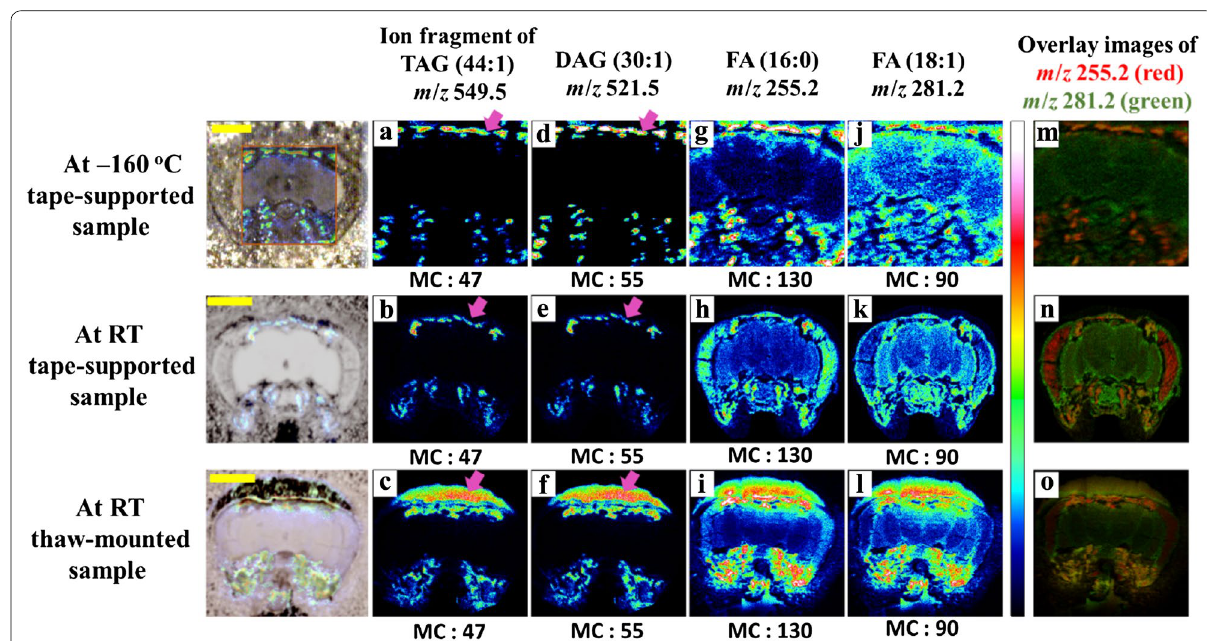
Fig. 3 Comparison of Drosophila brains prepared by three different preparation and analysis procedures. Tape-supported at low temperature ( a , d , g , j , m ), at room temperature ( b , e , h , k , n ), and thaw-mounted at room temperature ( c , f , i , l , o ). The distributions of positive ions at m / z 549.5—ion fragment of TAG (44:1), and 521.5—DAG (30:1), respectively, and negative ions at m / z 281.2 [FA (18:1), oleic acid] and m / z 255.2 [FA (16:0), palmitic acid]. Scale bar is 200 μm. MC stands for maximal counts (Reproduced from ref. [84] with permission, © John Wiley & Sons,